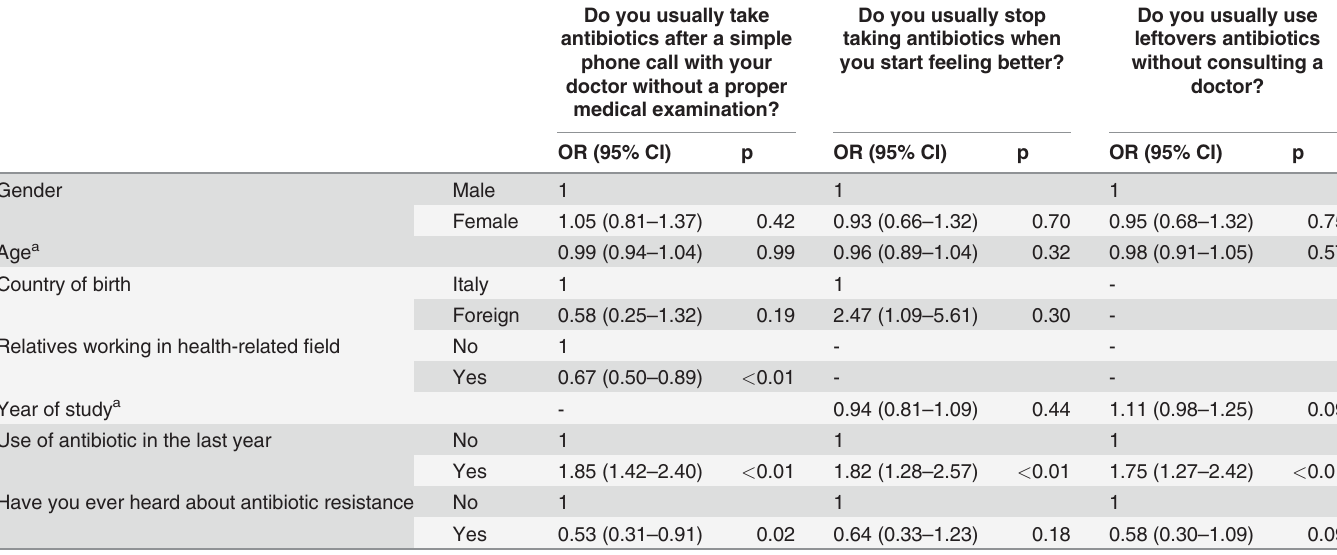
Table 4. Multivariate results on attitudes and behaviors about antibiotic consumption (N =